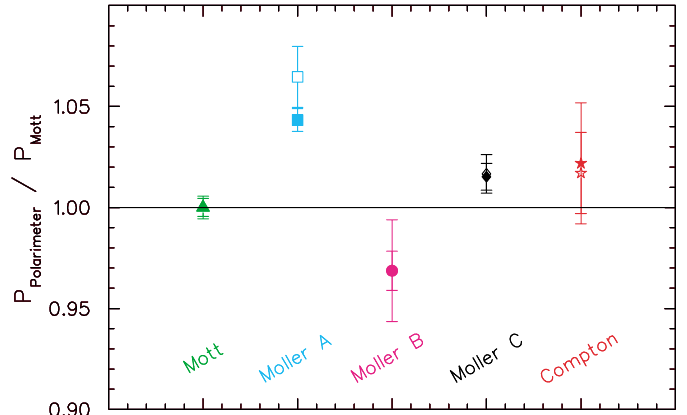
FIG. 11. (Color) The relative analyzing powers for the five Jefferson Laboratory electron beam polarimeters, normalized to the Mott polarimeter for comparison. The solid symbol markers represent the results for the data set limited to be within 25% of the maximum measured polarization. The open symbol markers are the results shown in Fig. 9.